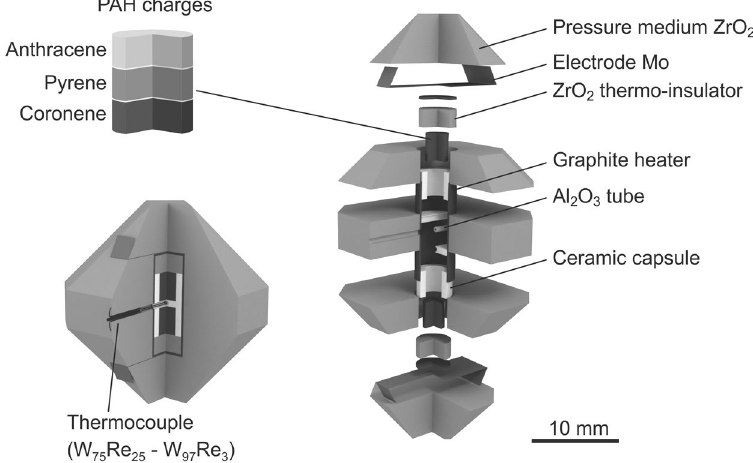
Figure 1. Schematic illustration of the high-pressure cell assemblage used for